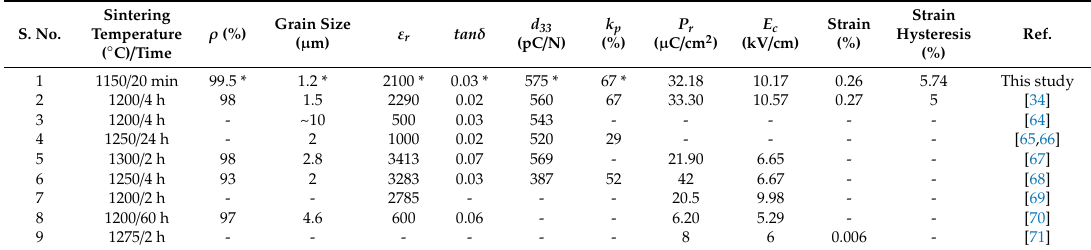
Table 6. Comparison between conventional and microwave-sintered PLZT 8 / 60 / 40 ceramics. The value of ε r and tan δ is reported at 1 kHz. The data reported in S. No. 8 and 9 are for the PLZT 9 / 60 / 40 composition. * Microwave-sintered data reported earlier